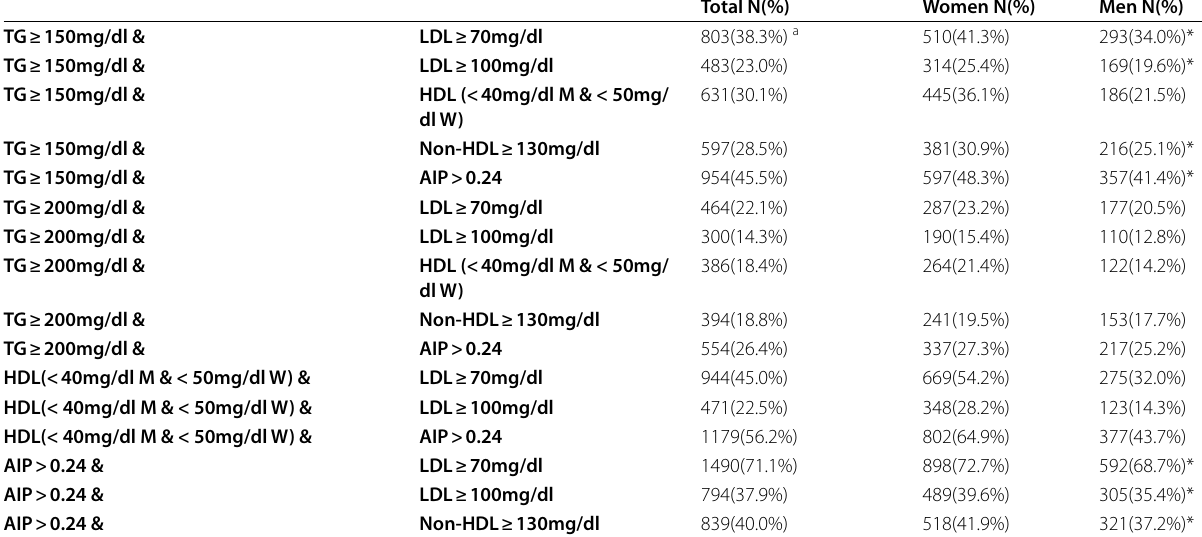
Table 2 Patterns of dual combination dyslipidemia in the studied